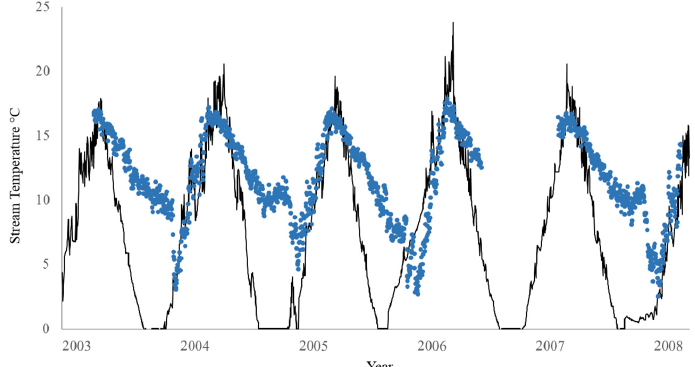
Figure 11. Observed ( blue dots ) and estimated ( black lines ) daily mean stream temperature from a site in the Middle Fork John Day River near Phipps Meadow. Estimated stream temperature is from models built using all the data for the HUC 4 encompassing the Middle Fork.